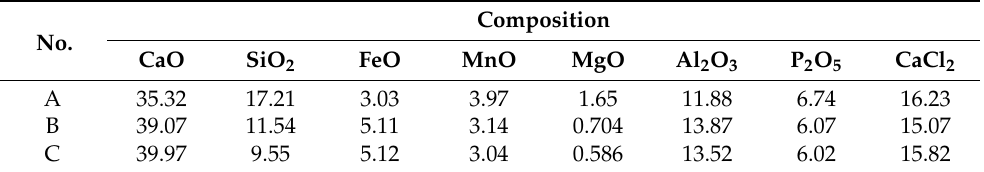
Table 4. Chemical composition of the final slag